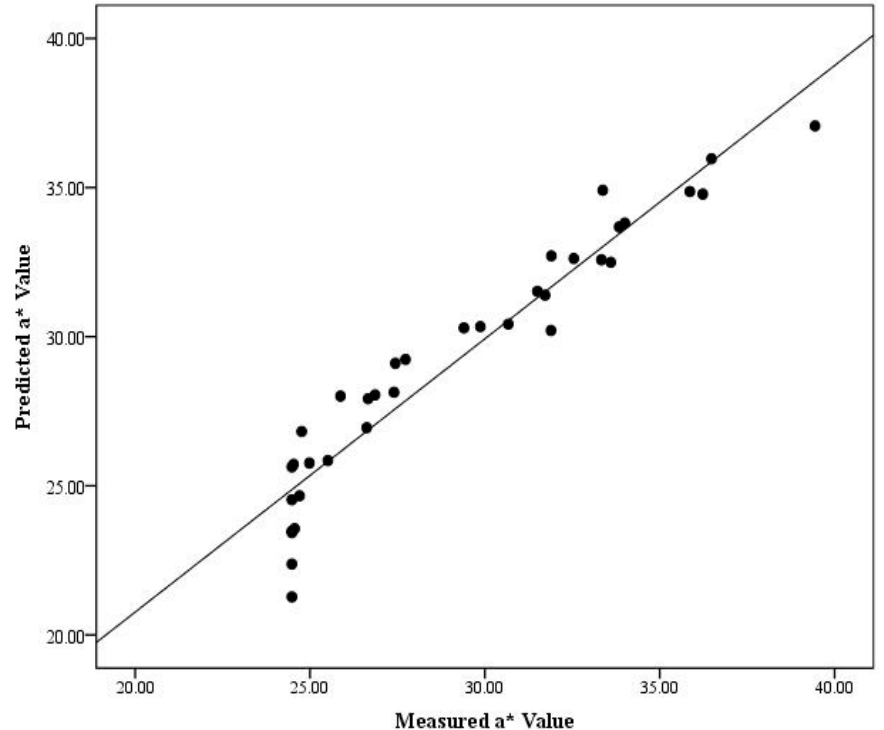
Figure 9. Results for the prediction of redness (a*) values based on linear regression models. The obtained results in total color change ( ∆ E *) after 10 days of storage were signifi- cantly higher for highly (32.04) impacted bruised tomatoes followed by the medium (27.35) and low (25.37) impact-bruised tomatoes stored at room temperature (22 ◦ C) (Table 2). Storage at 10 ◦ C and a low impact reduced the increase of ∆ E * for all bruised tomatoes after 10 days of storage. Generally, higher bruising induced higher color discoloration due to the increase in the ripening process of pear Bodner and Scampicchio [29]. Besides, Hussein et al. [8] revealed the significant influence of drop height, storage duration, and storage temperature on the ∆ E * of pomegranate fruit. Chroma showed a fluctuated value during storage at both storage conditions (Table 2). However, on the last day of storage, the highest (43.70) and lowest (39.30) values of chroma were observed for the high and low impacted tomato fruit stored at 10 and 22 ◦ C, respectively. Table 2 shows that the color purity (hue ◦ ) of the tomato sample declined sharply until the end of the storage duration, particularly for high-impact bruised tomatoes stored at room temperature (22 ◦ C). Overall, the rate of reduction in hue ◦ for high (647.75 mJ), medium (431.83 mJ), and low (215.91 mJ) drop-impacted bruised tomatoes was lower at 10 ◦ C storage conditions after 10 days of storage. Dobrzanski and Rybezynski [30] found that the color attributes of bruised apples were significantly affected by bruise damage. The gradual decline in hue ◦ at room temperature is attributed to the natural relation between storage conditions and biochemical reactions which increase with an increase of temperature [1].